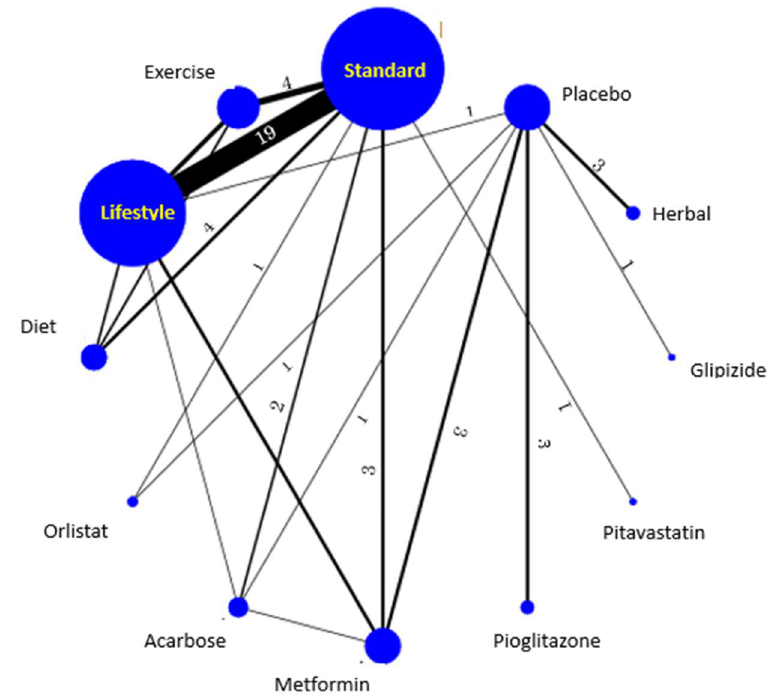
Figure 2. Network map of the 12 treatments by the frequentist model. The size of each node and the thickness of the lines are proportional to the number of studies reporting the treatments.